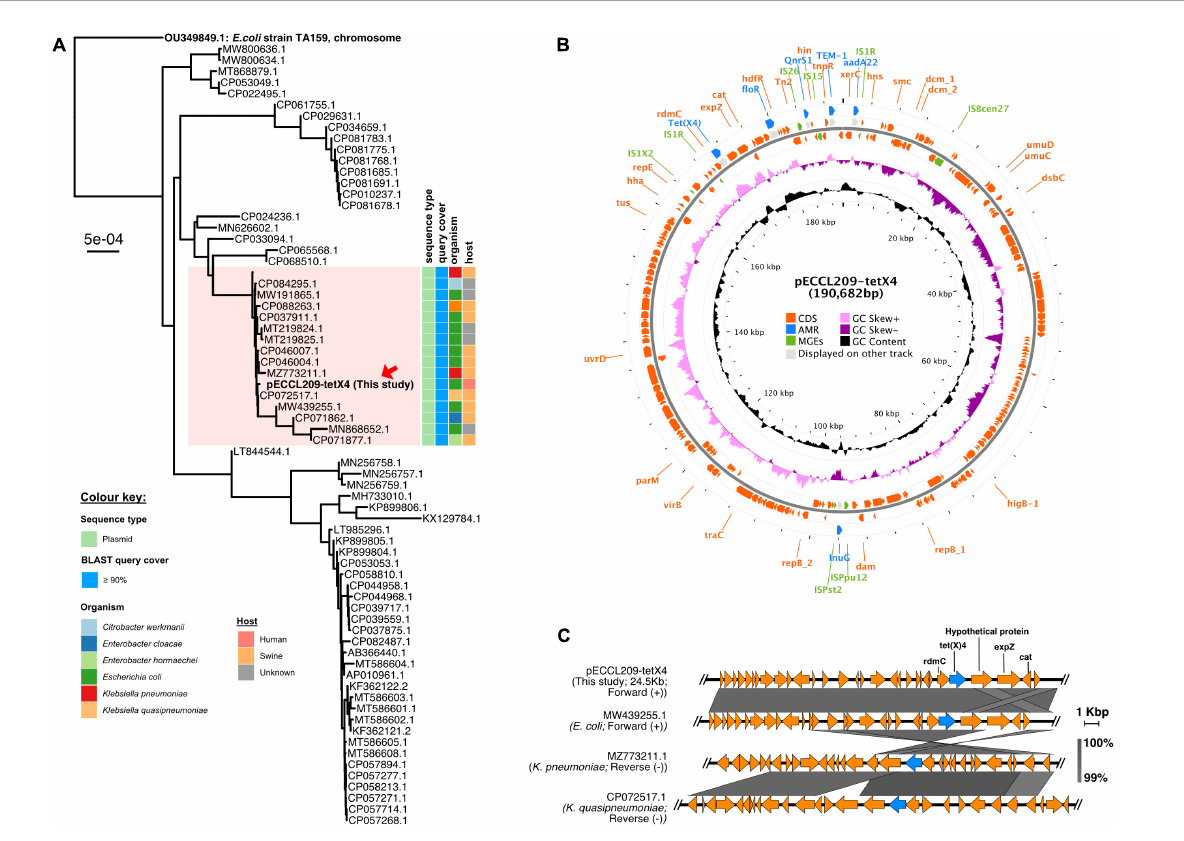
FIGURE1 Structure of the tet (X4)-carrying plasmid and comparison of the genetic context of tet (X4). (A) BLAST tree comparison of plasmid pECCL209-tetX4 with other homologous plasmids available in the NCBI database. (B) Structure of the tet(X4)-carrying plasmid pECCL209. (C) Sequence comparison of the genetic context of a plasmid carrying tet (X4) gene from different sources. The arrows showed the direction of the transcription. Regions of > 99% of homology are displayed by gray